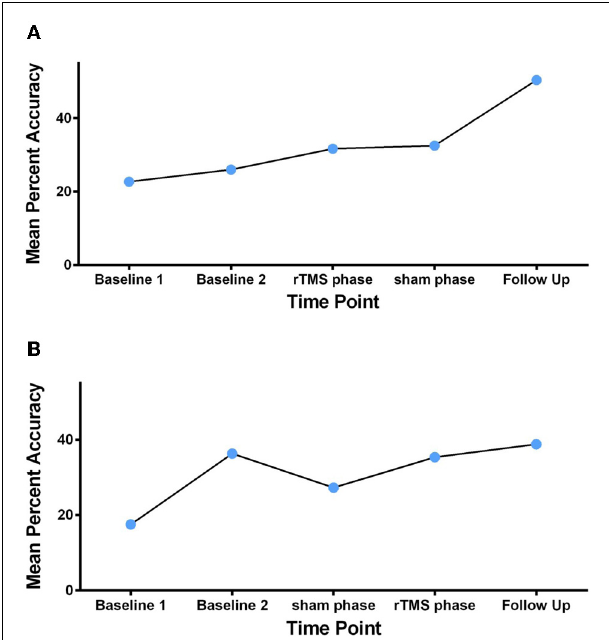
FIGURE 4 | Mean percent accuracy of verbal fluency at baseline, during the treatment phases, and at the follow up session for (A) participant GOE and (B) participant